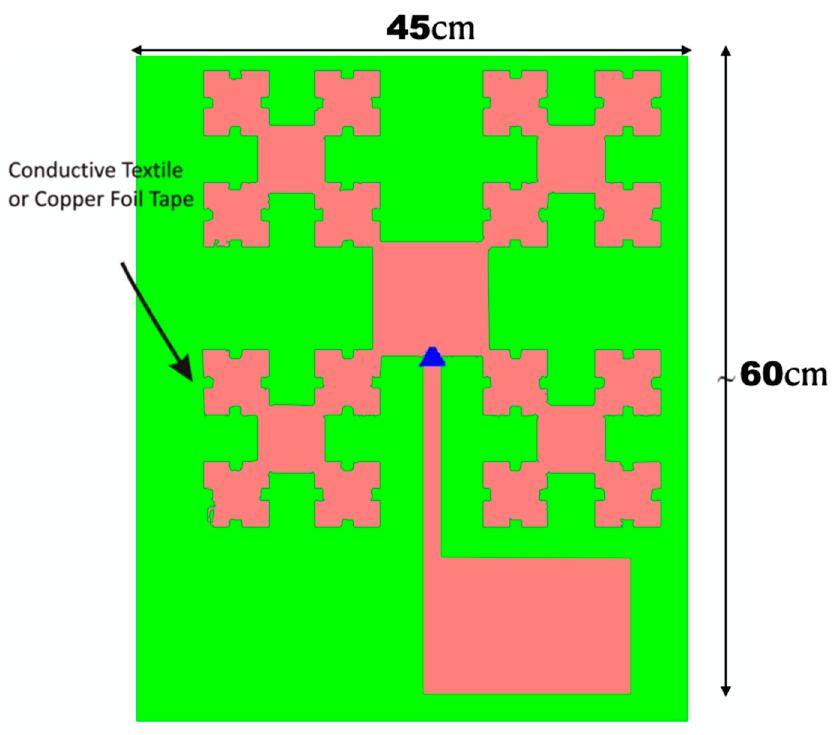
Figure 4. Large, flexible wearable antennas FM receiver (87–108 MHz); design based on [9].